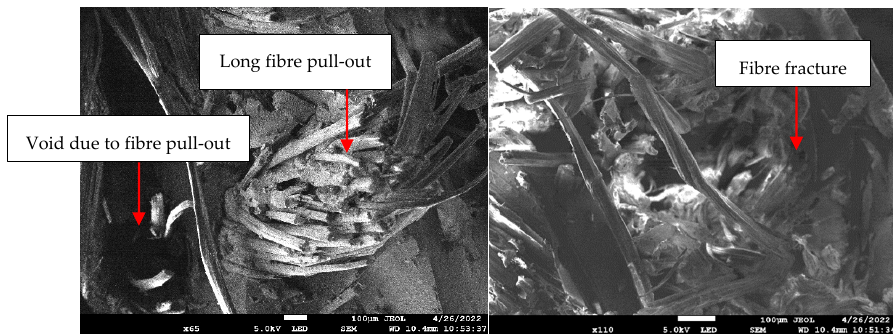
Figure 10. Scanning electron microscopy images of the PALF composites under tensile loading.